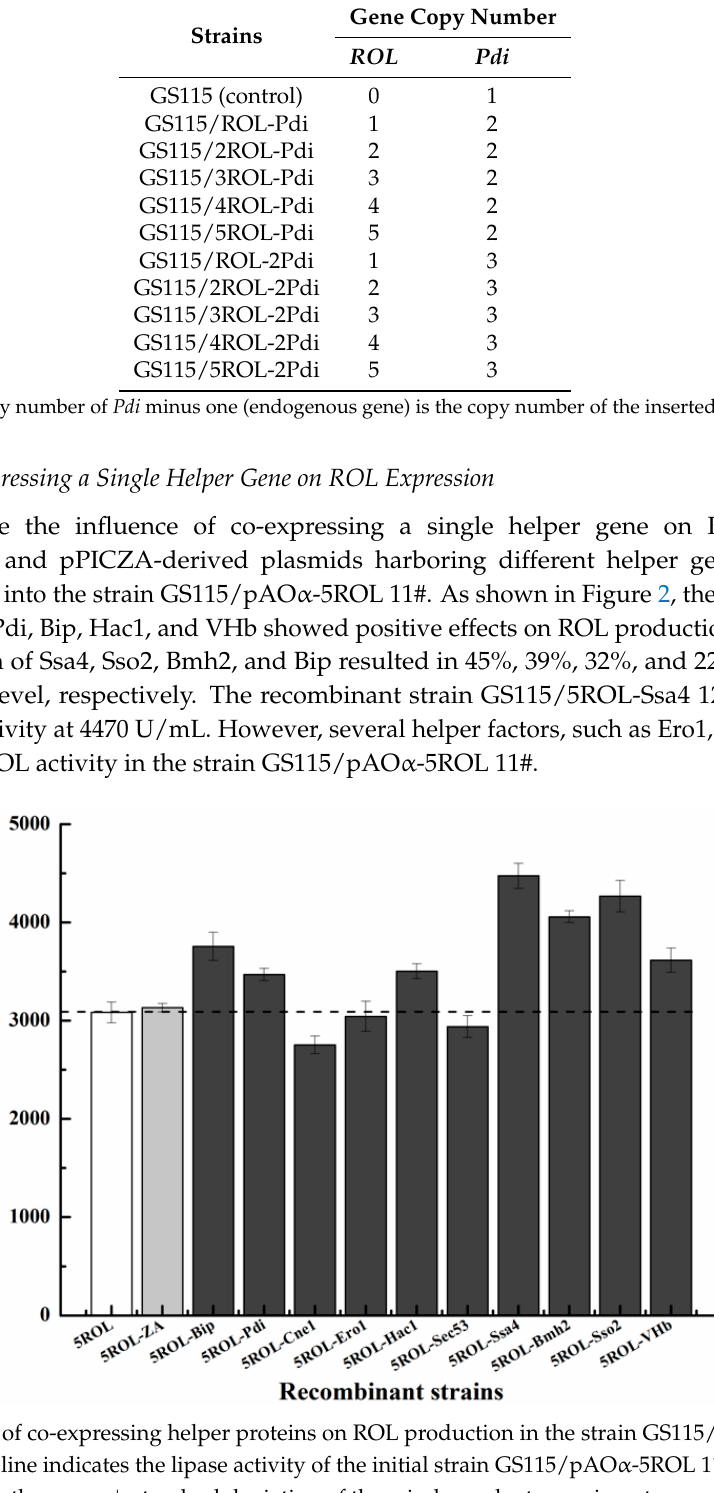
Table 1. Recombinant strains with different copy numbers of the Pdi gene and ROL gene 1 . Gene Copy Number Strains ROL Pdi